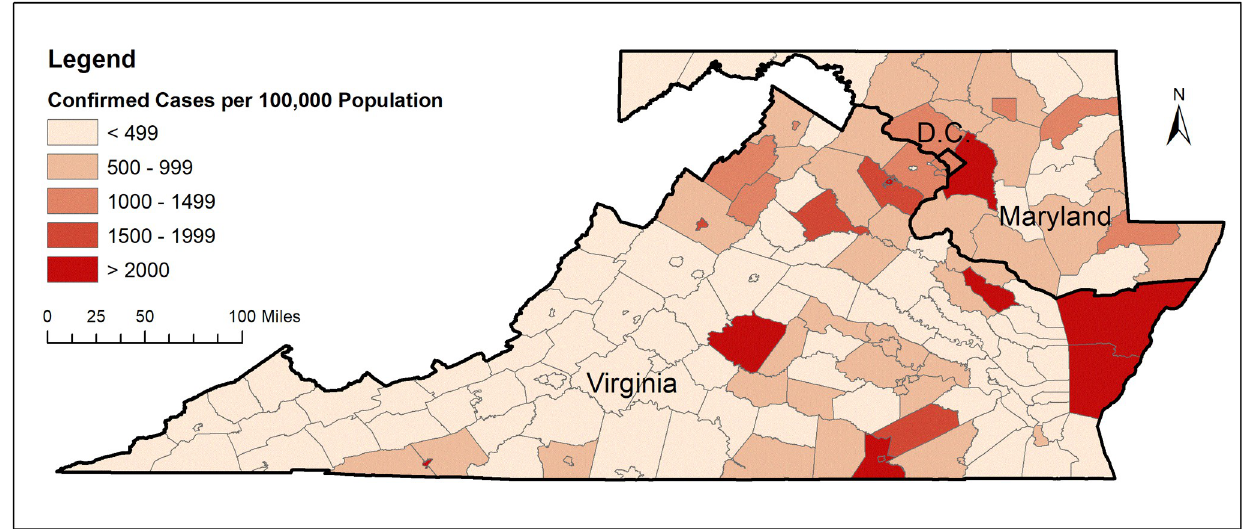
Fig 3. COVID-19 confirmed cases per 100,000 population for counties within the DMV area. Source of data: COVID-19 Data Repository by the Center for Systems Science and Engineering at Johns Hopkins University [30]. Data by June 30, 2020.